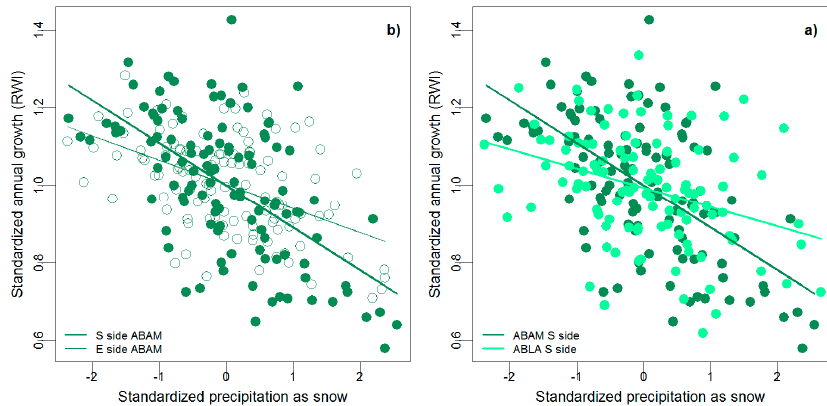
Figure 5. Significant differences in climate sensitivity ( a ) for A. amabilis growing on different sides of the mountain ( p = 0.0114) and ( b ) between A. amabilis and A. lasiocarpa on the same side of the mountain ( p = 0.0114). Table 2. Model selection for ring width indices as a function of climate, ring width as a function of climate with species interactions, with site interactions, and with both species and site interactions. Δ AIC is relative to the climate-only null model. A negative Δ AIC indicates that the model is better than the null. ◊ denotes the best model.